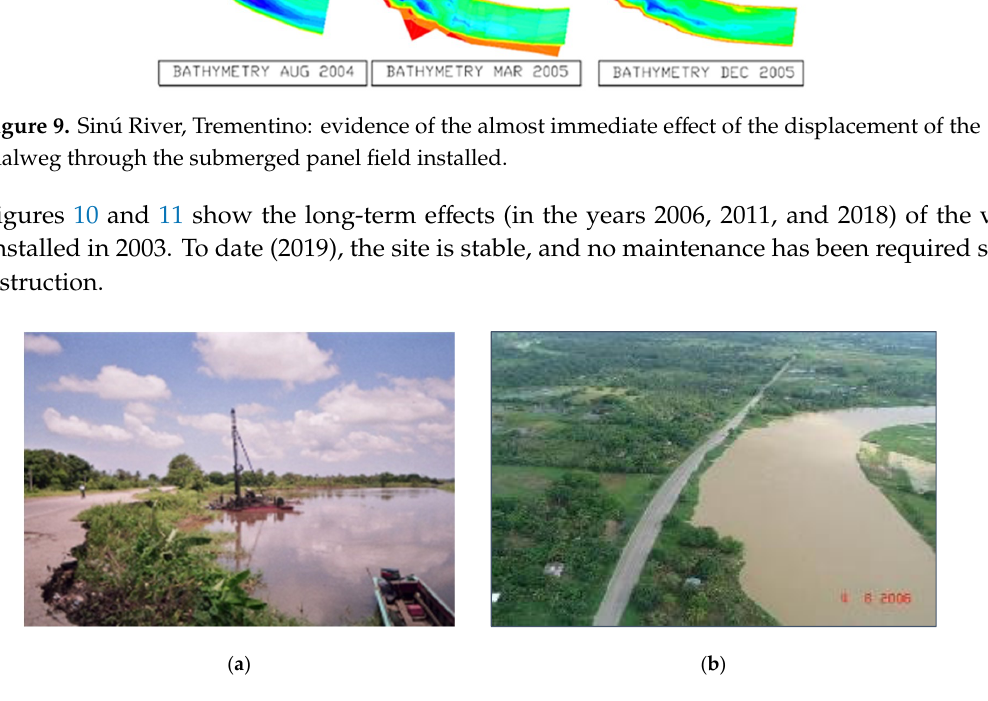
( b ) Figure 11. Sinú River, Trementino: ( a ) condition in March 2011, seven and a half years after installation; ( b ) condition in 2018, 13 years after installation (Hidroconsulta, 2011; ESRI, 2018 [11]). 3.3. Rio Metica, in Puerto López, Sector 2 (2007) The objective of the project was to control the evolution of a huge meander on the left bank of the Metica River in Puerto López through the so-called Phase 2 (Figure 12), which has approached the Puerto López–Puerto Gaitán highway at a rate of 39 m/year between 1939 and 2007 [12]. The road was less than 50 m from the river in 2005 (Figure 12a). A previous intervention consisted of six spurs built with two lines of metal pipe with the space between them filled with bags of concrete. Except for two of them (Figure 13), the spurs were soon destroyed by the river. Thus, it was decided to apply the submerged vane tecnology based on the geometry shown in Figure 12b (Hidroconsulta, 2005 [13]), which was adjusted two years later (Hidroconsulta, 2007 [12]) when its construction was initiated.